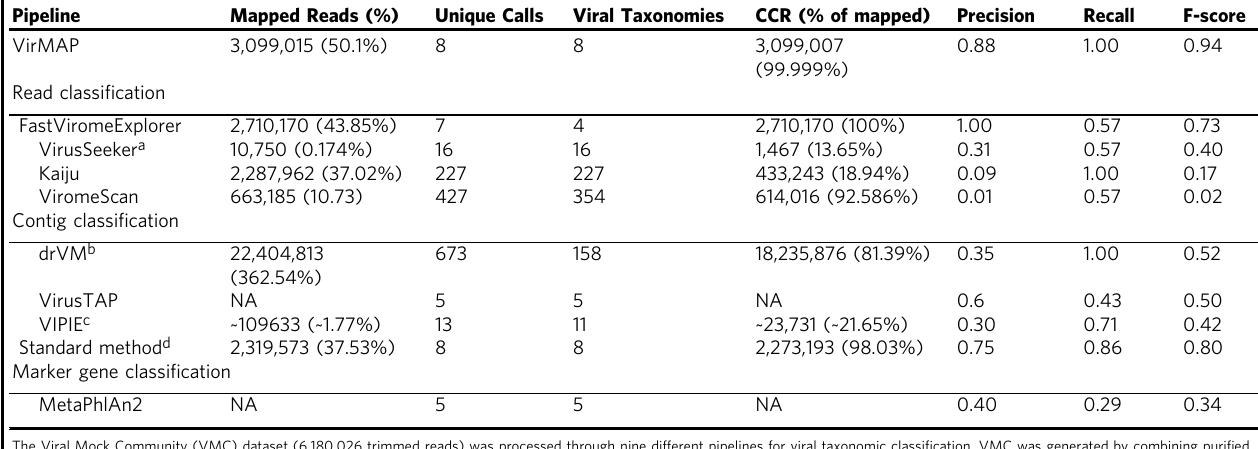
Table 1 Comparative analysis of ten viral sequence classi fi ers